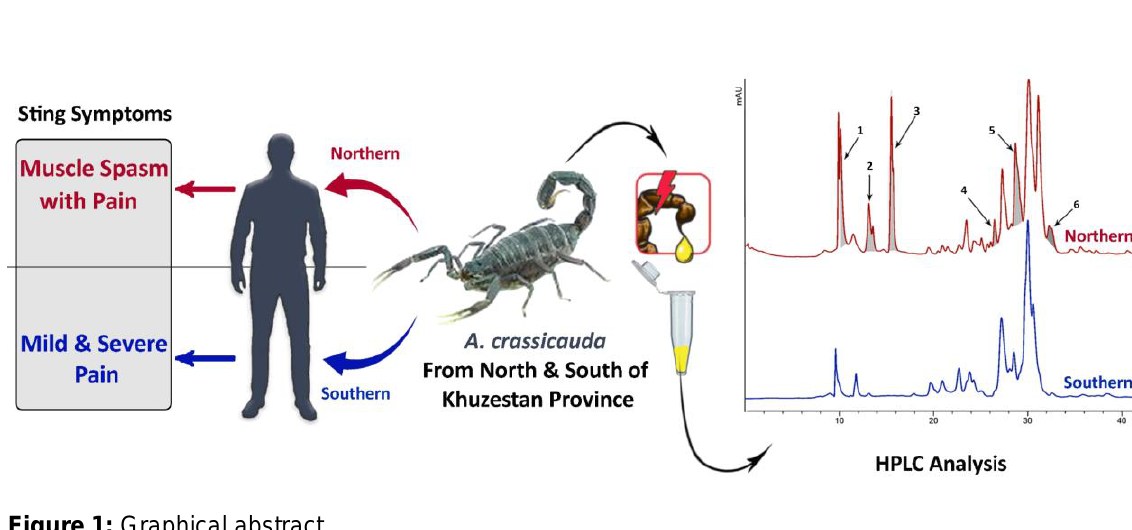
Envenomation by Androctunus crassicauda is very frequent in Iran, especially in the south-west . This scorpion is one of the six scorpions whose venom is used to prepare anti-venom. Using HPLC, we discovered venom compo- nents of A. crassicauda varies from one specimen to another depending on geographical location, and this result is confirmed by those first found in various symptoms of A. crassicauda sting in envenomed persons from two separate geographical places (north and south of Khuzestan province). There was a significant relationship be- tween symptoms and location of envenomation by A. crassicauda . Muscle spasm was more dominant in enven- omed people from Northern cities, and venom chromatogram analysis showed the presence of at least six main sharp peaks in Northern A. crassicauda rather than Southern A. crassicauda . It shows intraspecific differences in venom of A. crassicauda that must be considered in treatment of stung people from different geographical loca- tions as well as in the preparation of